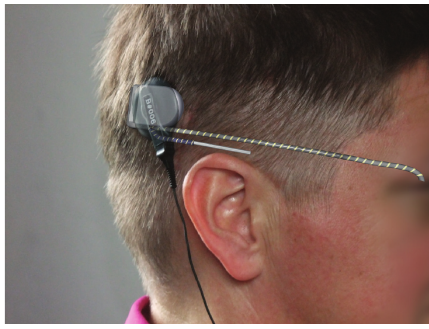
Figure3:Illustrationofthesubdermalplacementofthereceivercoil and the power supply cable (white/grey) in relation to the epidermal transmitter coil (black) and cable leading to the power supply in the patient’s